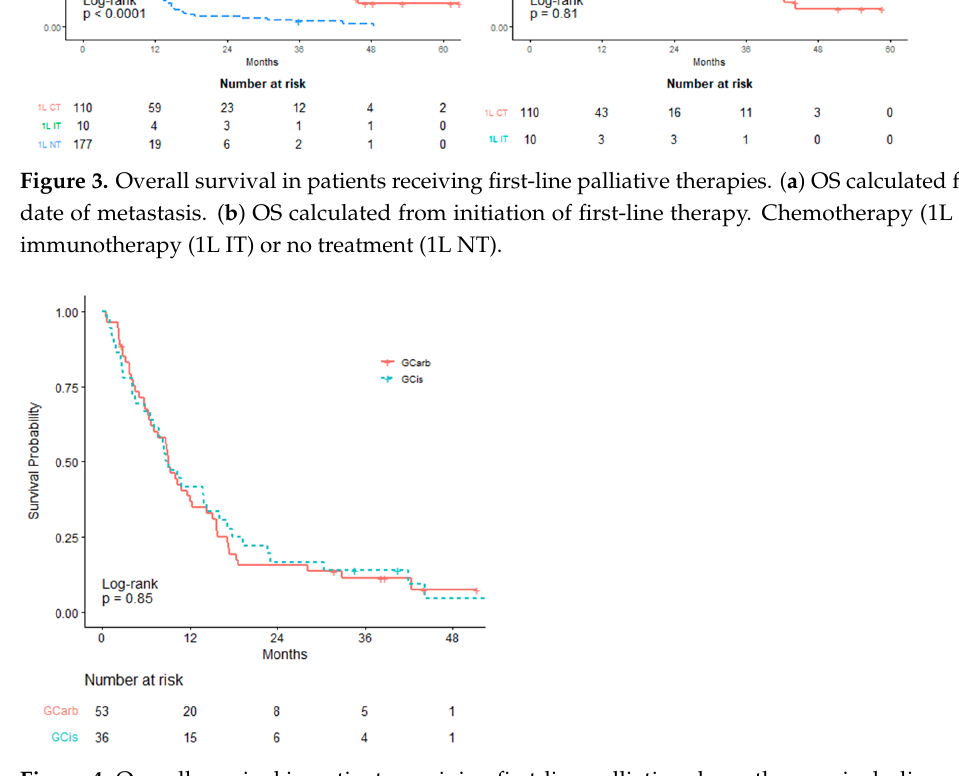
Figure 4. Overall survival in patients receiving first-line palliative chemotherapy, including: gem- citabine and cisplatin (GCis) vs. gemcitabine and carboplatin (GCarb), calculated from initiation of therapy.